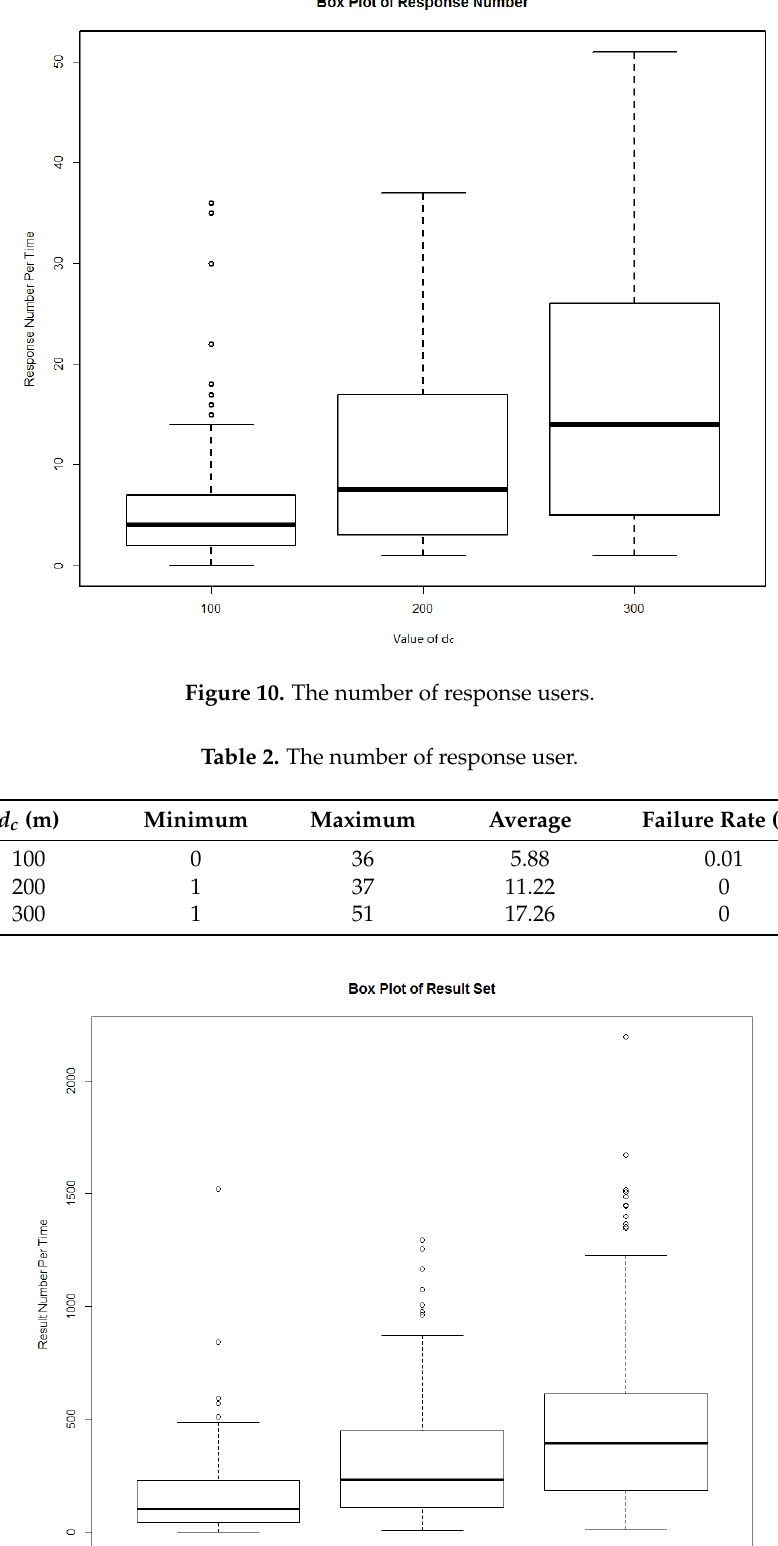
Table 3. Number of service result sets.